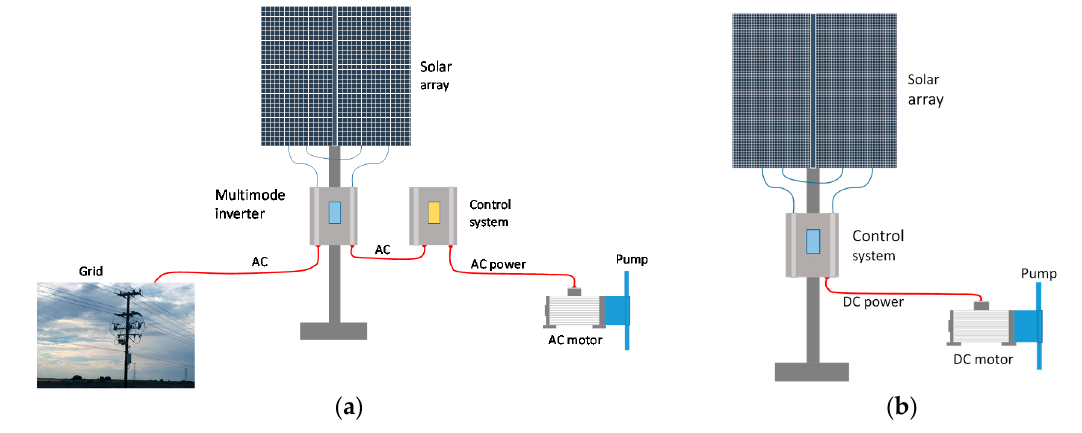
Figure 1. ( a ) Schematic of an on-grid photovoltaic (PV) irrigation system. ( b ) Schematic of an off-grid PV irrigation system.